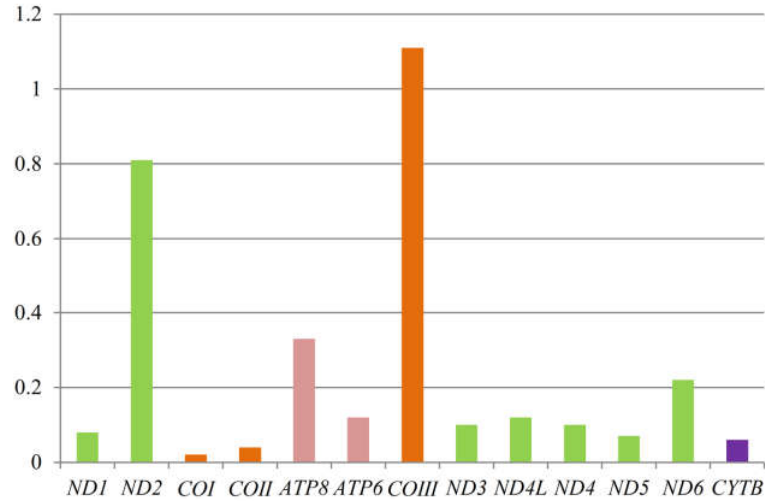
Figure 5. The nonsynonymous/synonymous ratios (dN/dS) in 13 mitochondrial PCGs of 58 taxa in Lacertidae. The histogram represents the average dN/dS for each PCG.